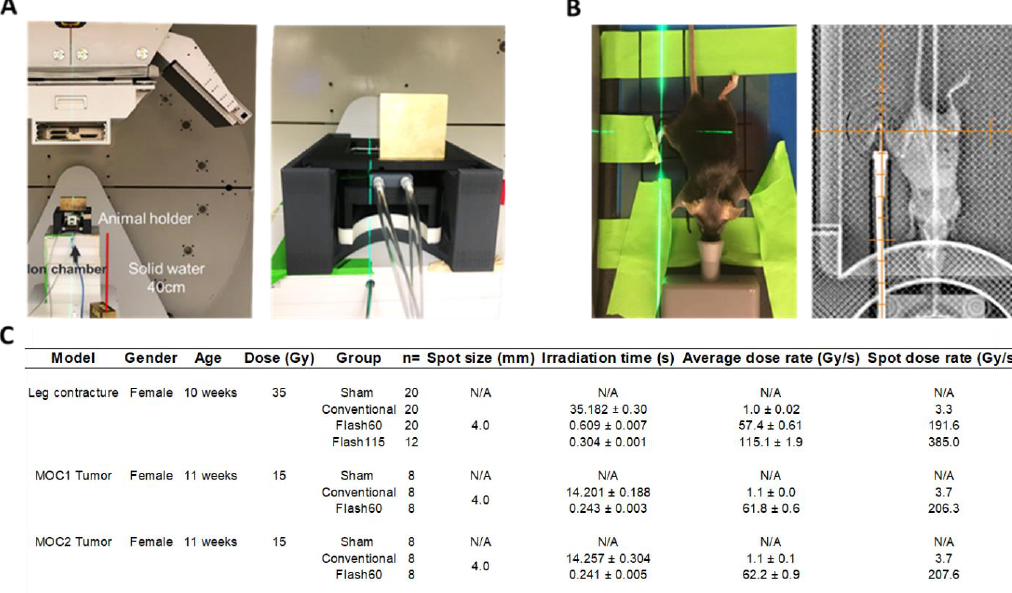
Figure 1. Irradiation approach for PBS radiation of the murine hind leg. ( A ) Representative picture of the animal holder, ion chamber and beam blocker set up in the proton gantry used for all irradiations. ( B ) Representative pictures of the alignment strategy, showing the mouse being first positioned on gafchromic film in the removable holder bed and validation of alignment by the gantry X-ray system. ( C ) Description of beam delivery parameters for the different mouse groups and experimentations. Values are expressed as the average ± SD. PBS: pencil beam scanning. 2.2. TGF-β1 Production Is Attenuated Following FLASH PBS versus Conventional Radiation To measure the effect of FLASH versus conventional PBS on skin and soft tissue tox- icity, the right hind leg of C57BL/6 female mice was irradiated. Mice were randomly sepa- rated into groups and irradiated with a total of 35 Gy at either 1 Gy/sec (Conv), 57 Gy/s (Flash60) or 115 Gy/sec (Flash115). TGF-β1 has been widely reported as a marker of tissue damage, and causes radiation-induced fibrosis in lung and skin tissue [26,27]. Moreover, TGF-β1 levels are known to increase in skin and blood in the acute phase of the radiation- induced stress response [28–30]. Therefore, we measured systemic and local levels of TGF- β1 in sham or PBS-irradiated mice at day 1 (blood) and day 4 (blood and skin) post radiation in order to quantify the acute radiation response (Figure 2). As expected, Conv irradiation induced an increase of TGF-β1 level in the blood at day 1, and this increase was sustained at day 4 post IR (Figure 2A). On day 1, TGF-β1 levels in the Flash60 and Flash115 groups were above Sham but below Conv levels. On day 4, TGF-β1 levels in those same groups were reduced down to baseline. Decreased latent and active TGF-β1 levels were also ob- served in the irradiated skin on day 4 for the FLASH groups compared to Conv (Figure 2B). Thus, FLASH PBS versus Conv leads to attenuated TGF-β1 production following radia- tion, and this might indicate a diminished radiation-induced stress response in both blood and skin.